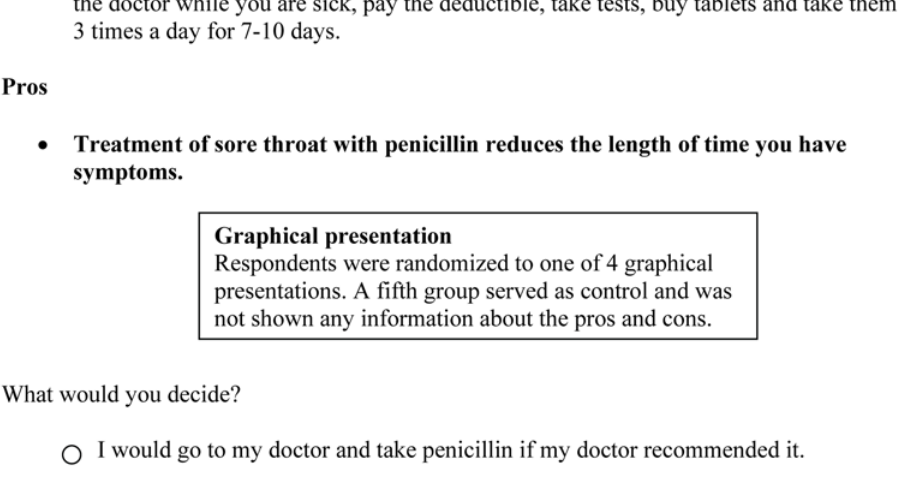
Figure 3. Downsides of antibiotics and decision elicitation.